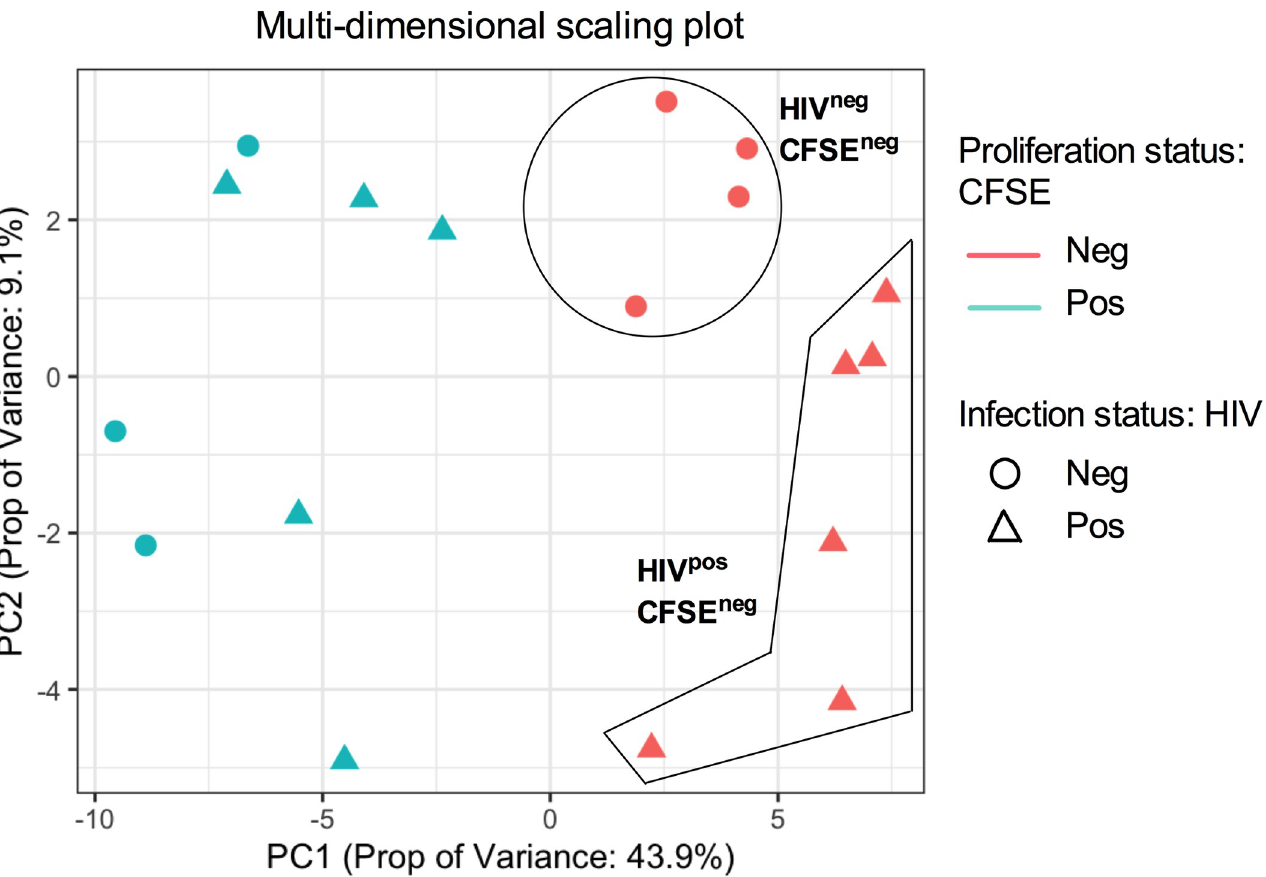
Fig 2. Multi-dimensional Scaling Plot (MDS) reveals unique proliferation- and infection-related gene profile clustering in GC-Tfh cells from HIV pos versus HIV neg individuals. We performed single-gene analysis of divided/activated versus non-proliferating LN GC-Tfh cells after 5 days of co-culture with autologous GC-B cells from HIV pos patients versus healthy subjects. Principle component (PC) analysis shown in the MDS plot along the first and second principle components, provides a visual representation of the similarity or distance between datasets from all samples. GC-Tfh cells were analyzed based on whether they are proliferating (CFSE negative CFSE neg : pink data points) or non-proliferating (CFSE positive CFSE pos : green data points), but also based on infection status (HIV negative HIV neg : circles or HIV positive HIV pos : triangles). MDS plot shows gene expression clustering between proliferating versus non- proliferating GC-Tfh cells as well as between proliferating HIV pos versus HIV neg GC-Tfh cells. Each symbol represents one sample. CFSE neg HIV neg : n = 4; CFSE neg HIV pos : n = 6; CFSE pos HIV neg : n = 3; CFSE pos HIV pos : n = 5).